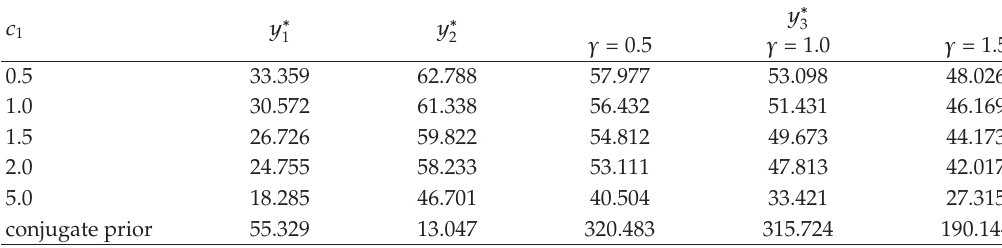
Table 3: Estimated future observation for the data set under three di ff erent loss functions.